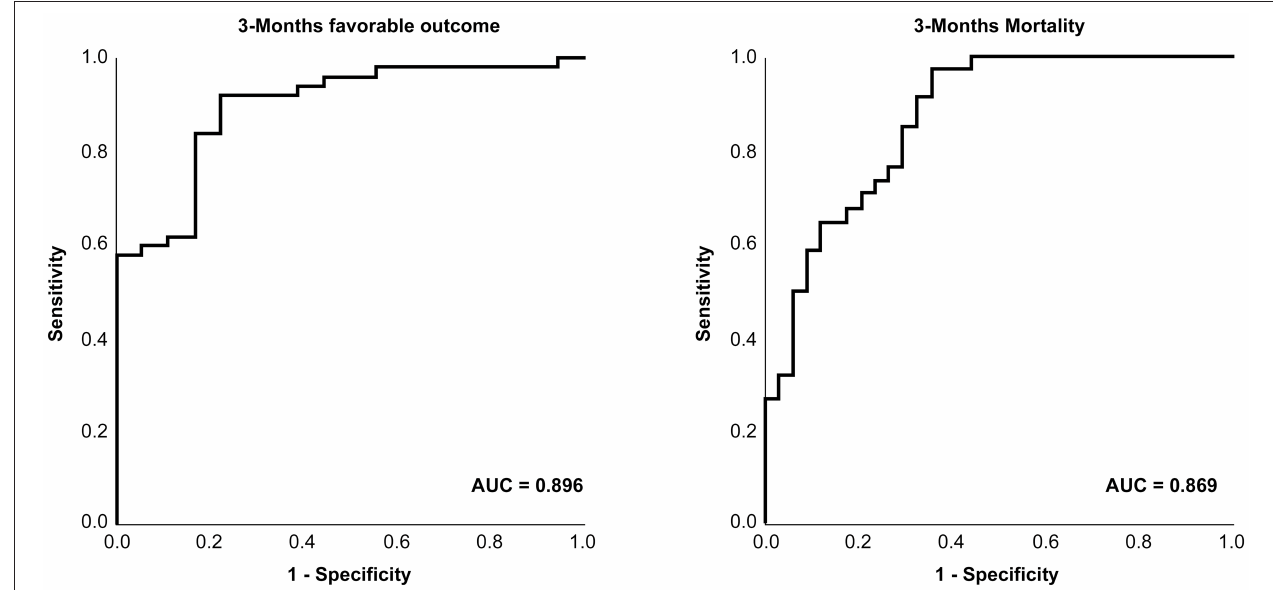
FIGURE 3 | Receiver operating characteristic curve of D -dimer for the prediction of patient clinical